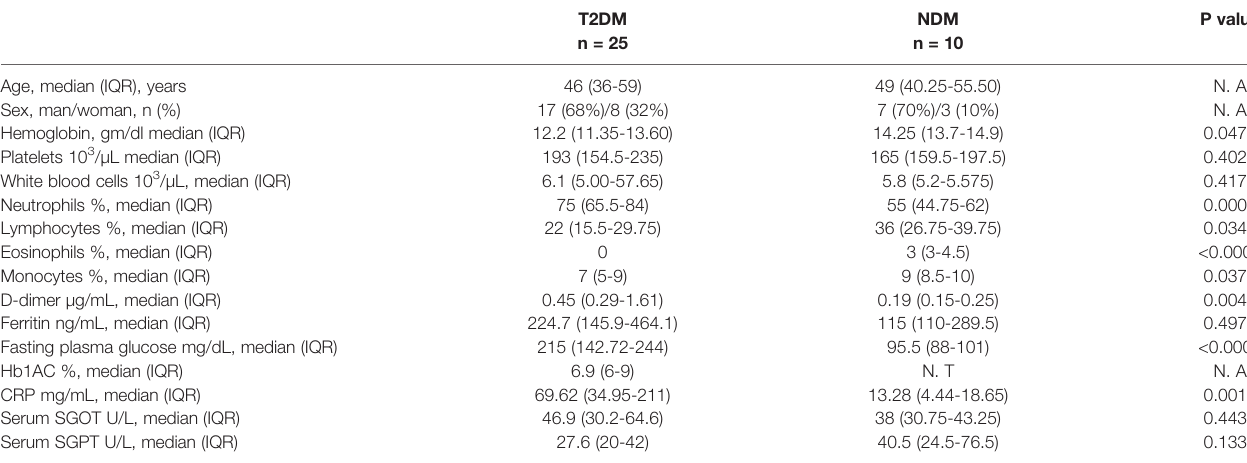
TABLE 1 | Demographic details and laboratory fi ndings of T2DM and NDM patients infected with